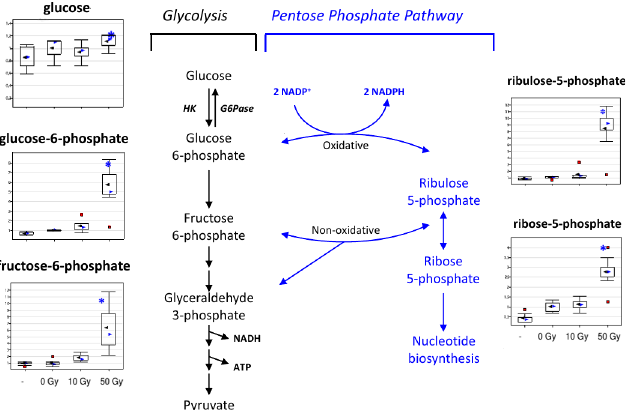
Fig 10. Pentose Phosphate Pathway changes in response to liver irradiation. The pentose phosphate pathway generates NADPH, ribose 5-phosphate, and intermediates of the glycolytic pathway. The NADPH is utilized for reductive pathways, such as fatty acid biosynthesis and the glutathione defense system against injury by reactive oxygen species. Ribose 5-phosphate provides the sugar for nucleotide synthesis. Increased levels of pentose phosphate intermediates may indicate altered glucose and/or nucleotide